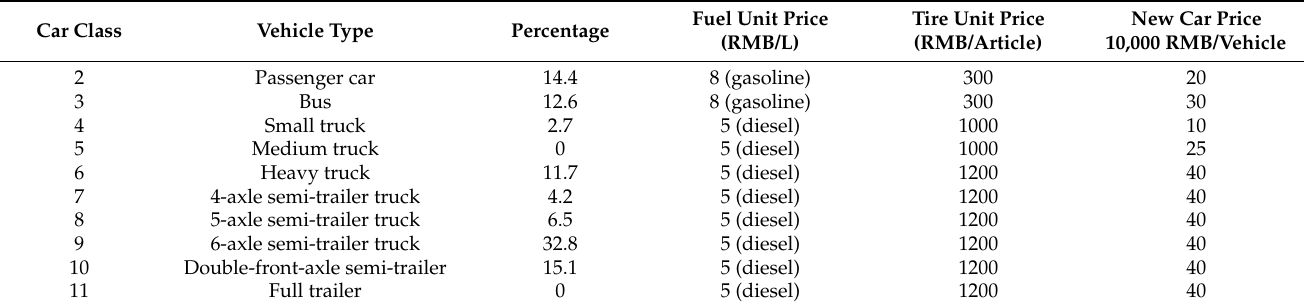
Table 16. Fuel, tire and new car